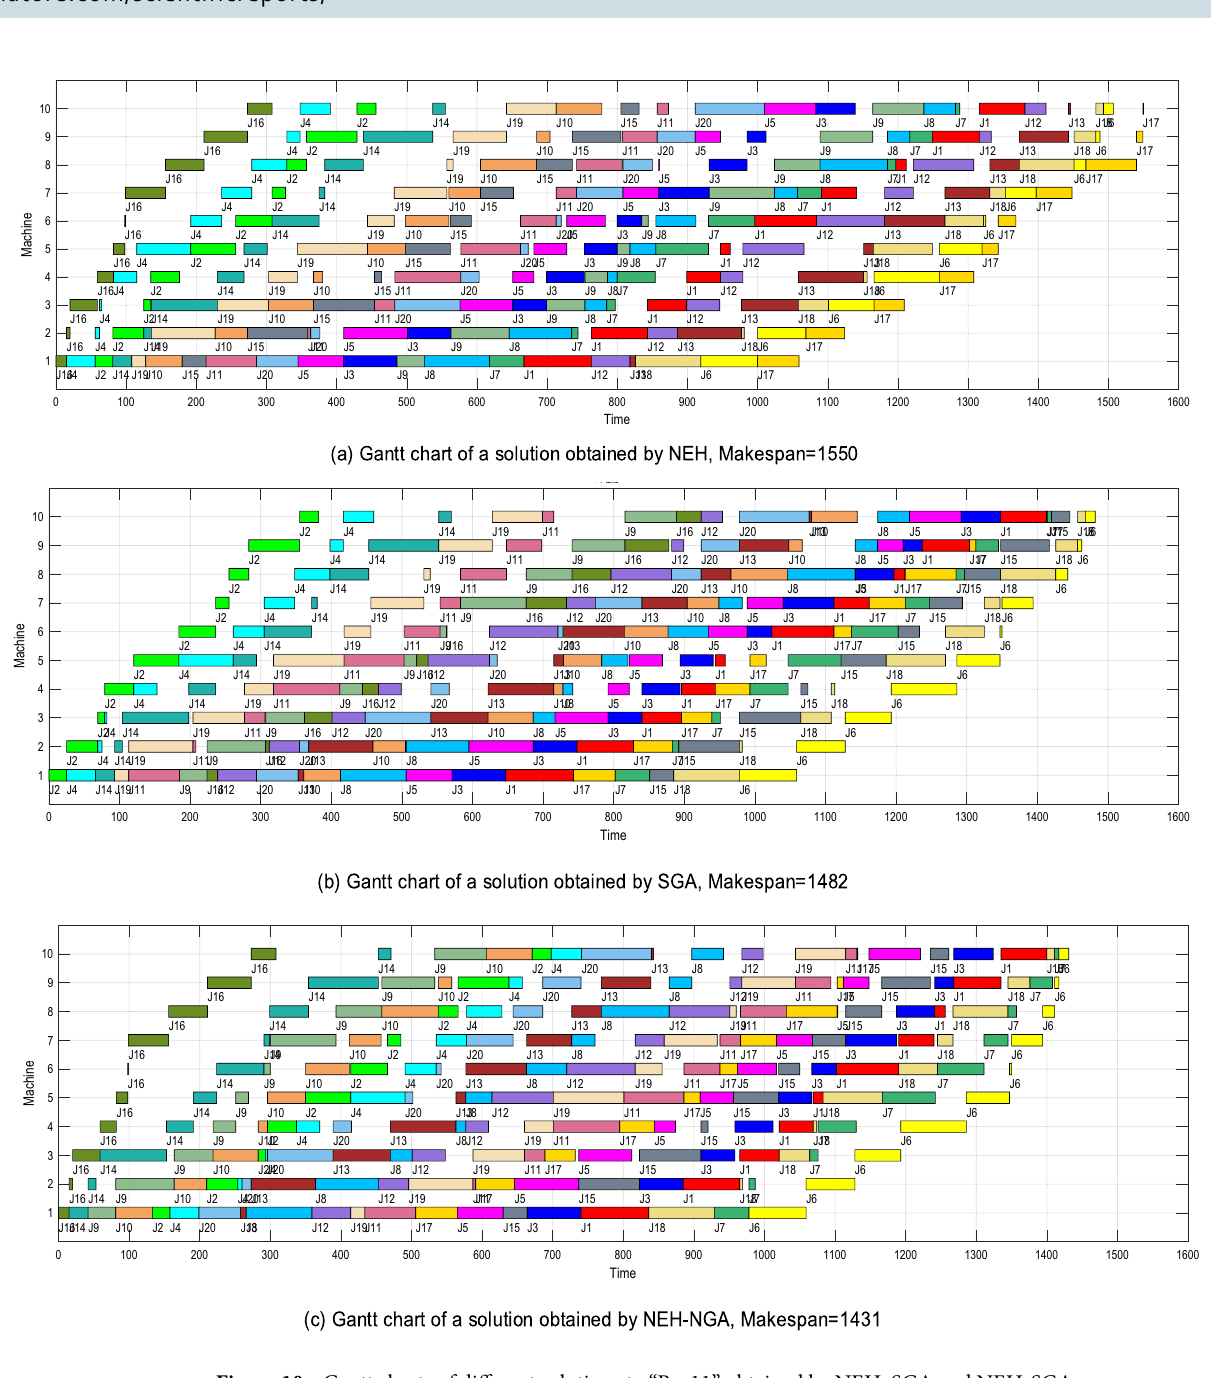
Figure 10. Gantt charts of different solutions to “Rec11” obtained by NEH, SGA and